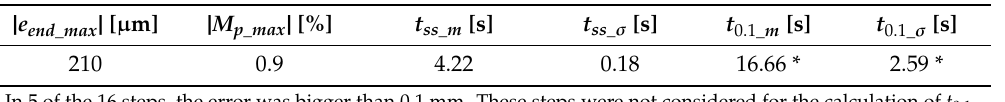
Figure 4. I-PD positioning test results: ( a ) position vs. reference; ( b ) error evolution in time; ( c ) detail of (b), showing the step where M p_max occurred. Table 2. I-PD controller performance metrics.